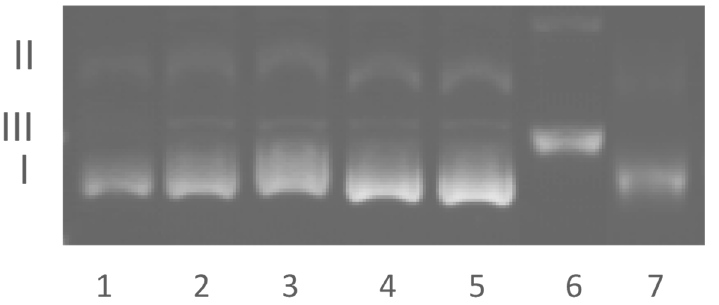
Figure 4. Gel electrophoresis diagram showing the cleavage of DNA in the SC form (pUC57 plasmid). Interaction of the compounds 3a , 3b , 3c with double-stranded DNA. Legend: 1-control DNA in DMSO; 2-DNA + 300 µ M 3b ; 3-DNA + 200 µ M 3b ; 4-DNA + 100 µ M 3b ; 5-DNA + 100 µ M 3c ; 6-DNA + 200 µ M 3c ; 7-DNA + 100 µ M 3a .